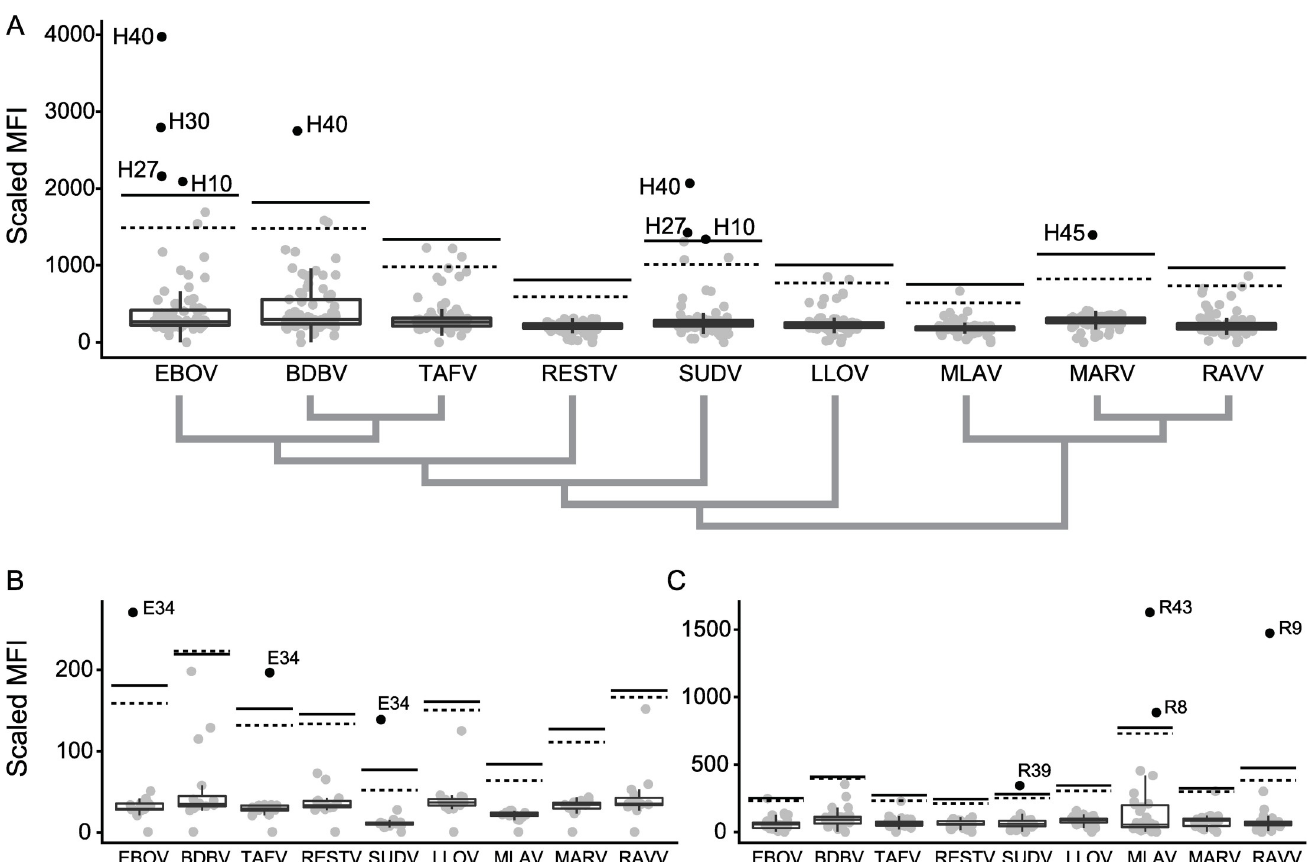
Fig 2. MFI values for sera obtained from humans (A), Eonycteris spelaea (B), Rousettus leschenaultii (C). Antibodies reactive to filovirus GPe from Ebola virus (EBOV), Bundibugyo virus (BDBV), Ta ï Forest virus (TAFV), Sudan ebolavirus (SUDV), Reston virus (RESTV), Lloviu virus (LLOV), Meˇngl à virus (MLAV), Marburg virus (MARV), and Ravn virus (RAVV) are quantified in a bead-based fluorescence assay. Grey dots represent individual samples. A boxplot is overlaid to indicate median, quartiles and extremes of the sample distribution. A black dashed line indicates the cutoff determined from a single lognormal curve-fit and a black solid black line the three-fold increase over the mean. A cladogram in panel A indicates the phylogenetic relationships of individual filovirus GPe based on their amino acid